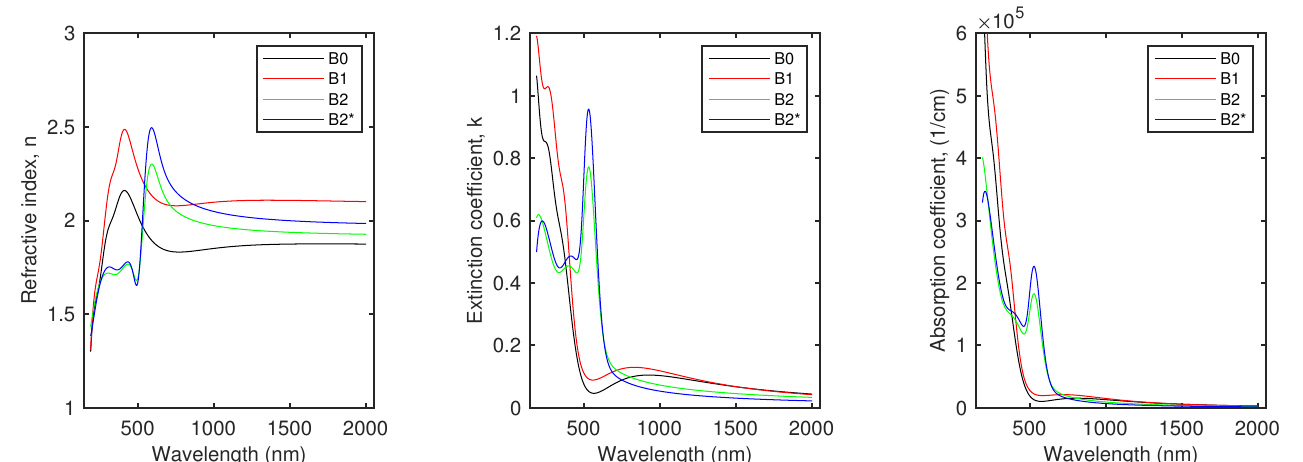
Figure 4. Refractive index ( n ), extinction coefficient ( k ), and absorption coefficient ( α ) determined for series B. Spectra for the other samples are presented in the Supplementary